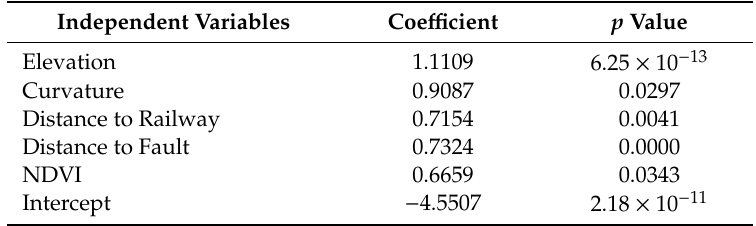
Table 5. Variables contained in the LR model and their coe ffi cients.